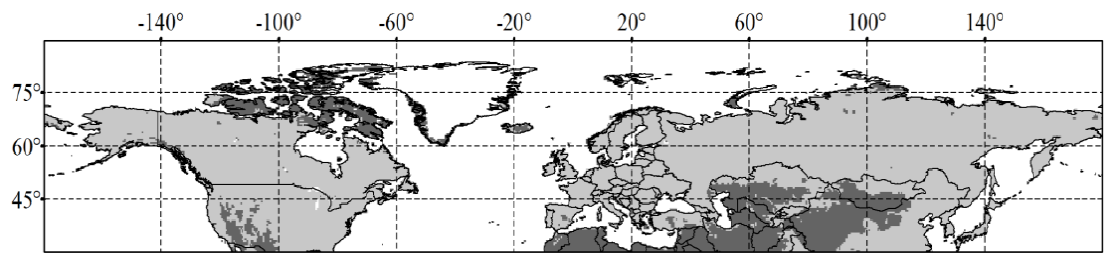
Figure 1. Vegetated area (light gray) identified in this